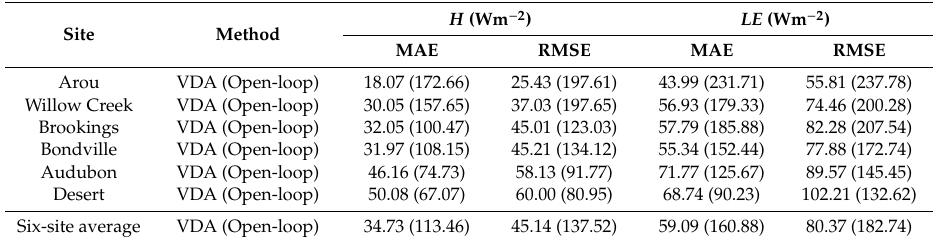
Table 6. MAE and RMSE of daily H and LE estimates from the VDA and open loop approaches at the six experimental